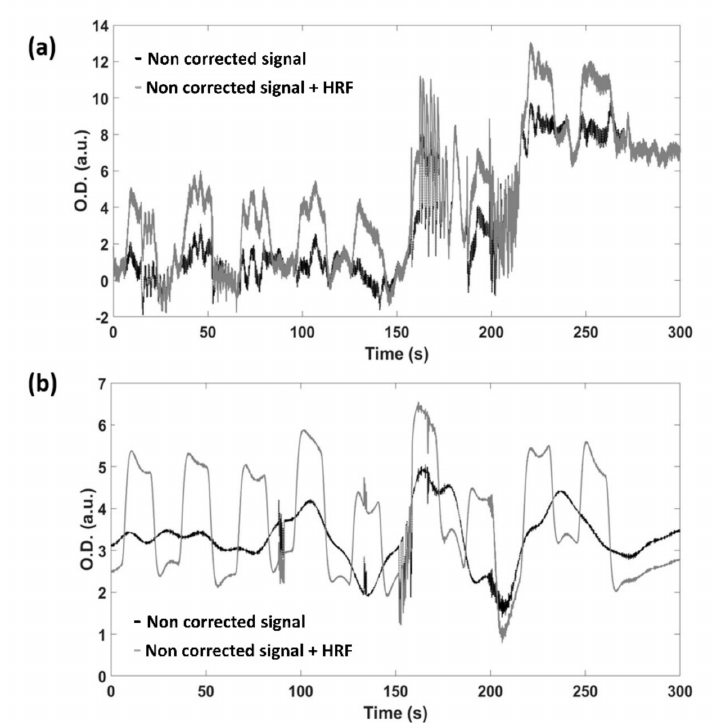
Figure 7. Example of one signal obtained by adding the synthesized HRF in the experimental paradigm simulated to the real resting state fNIRS data, before ( a ) and after ( b ) the application of the artifacts removal algorithm.